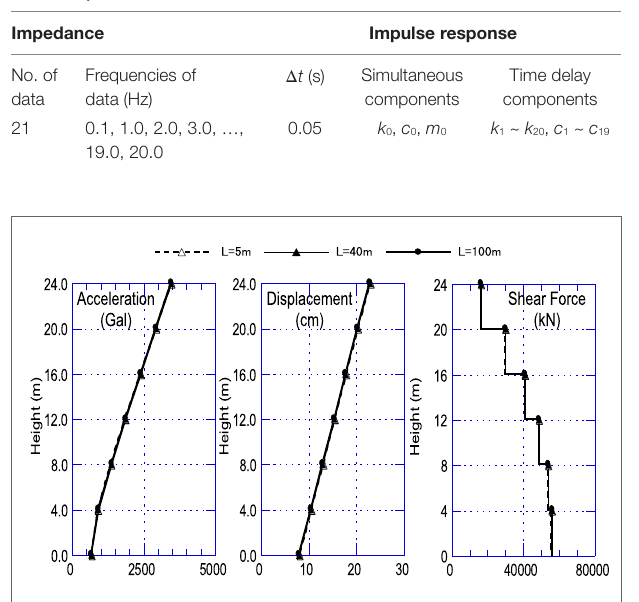
FigUre 7 | Maximum responses of building (VB, sh problem) .